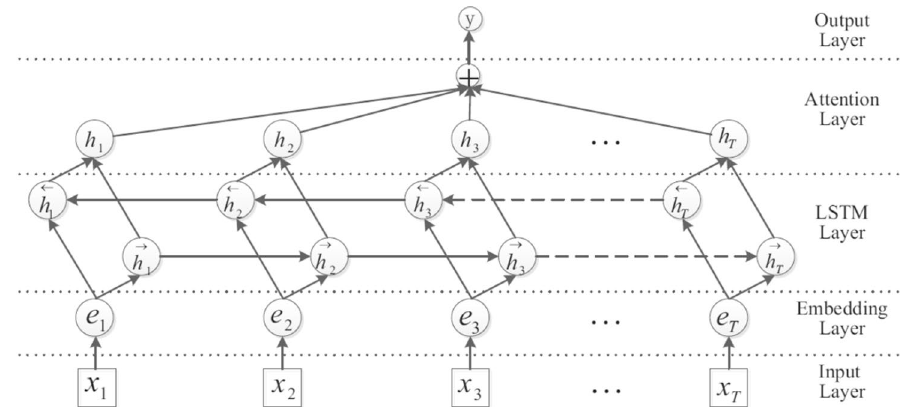
Fig. 1 Bi-LSTM attention structure